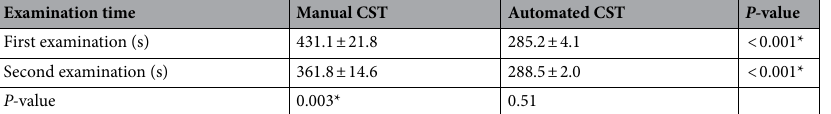
Table 2. Mean time taken to complete one full examination using manual and automated CST. *Indicates statistically significant results.